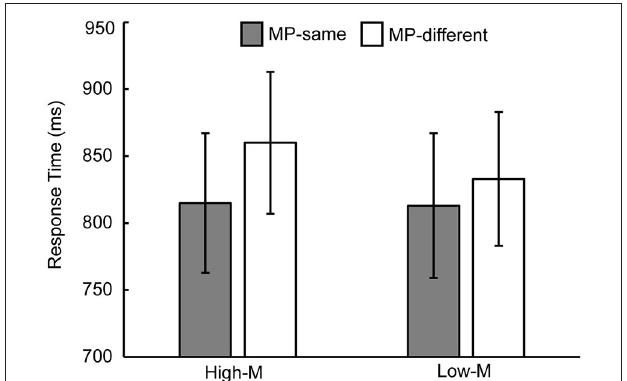
FIGURE 2 | Response time measures of masked priming effect . Average response times for MP-same and MP-different stimuli as a function of meaningfulness. The error bars indicate standard error.